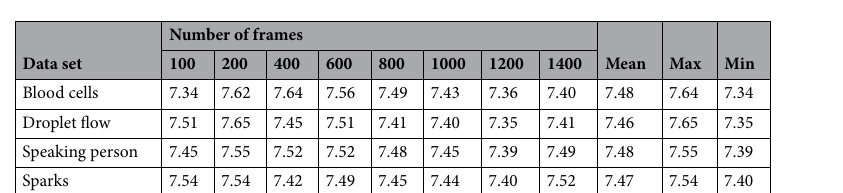
Figure 7. SSIM values of decrypted data at various noise levels for additive Gaussian noise and salt and pepper noise.